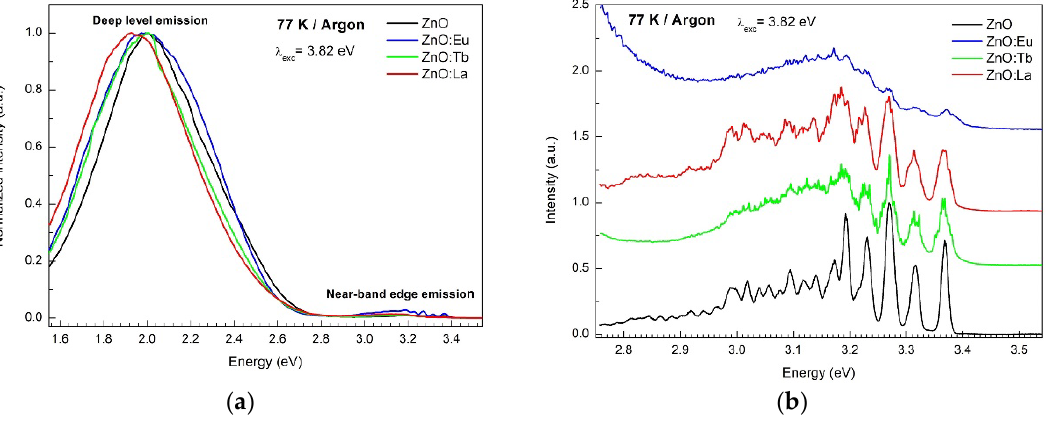
Figure 8. ( a ) PL emission spectra performed at 77 K of ZnO, ZnO:Eu, ZnO:Tb, and ZnO:La NPs; ( b ) PL emission spectra magnified in the near-band edge region. ( b ) PL emission spectra magnified in the near-band edge